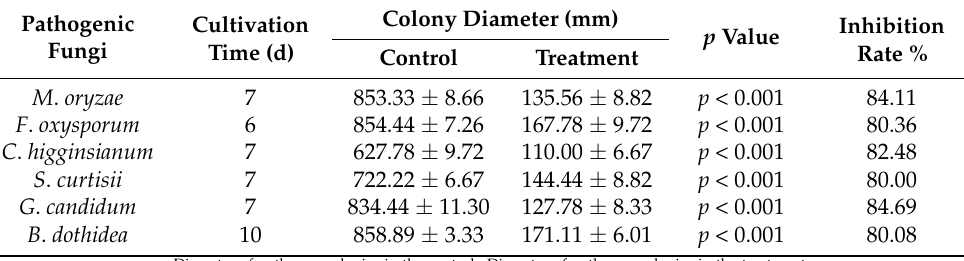
Figure 2. BsNLG8 and antagonistic culture of pathogenic fungi. ( a ) M. oryzae , ( b ) F. oxysporum , ( c ) G.candidum , ( d ) S. curtisii , ( e ) C. higginsianum , and ( f ) B. dothidea . Table 2. Inhibition rate of BsNLG8 against phytopathogenic fungi.